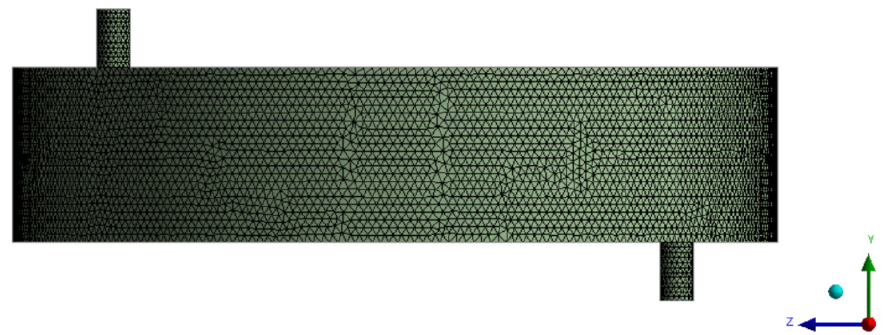
Figure 2. Overall mesh division diagram.